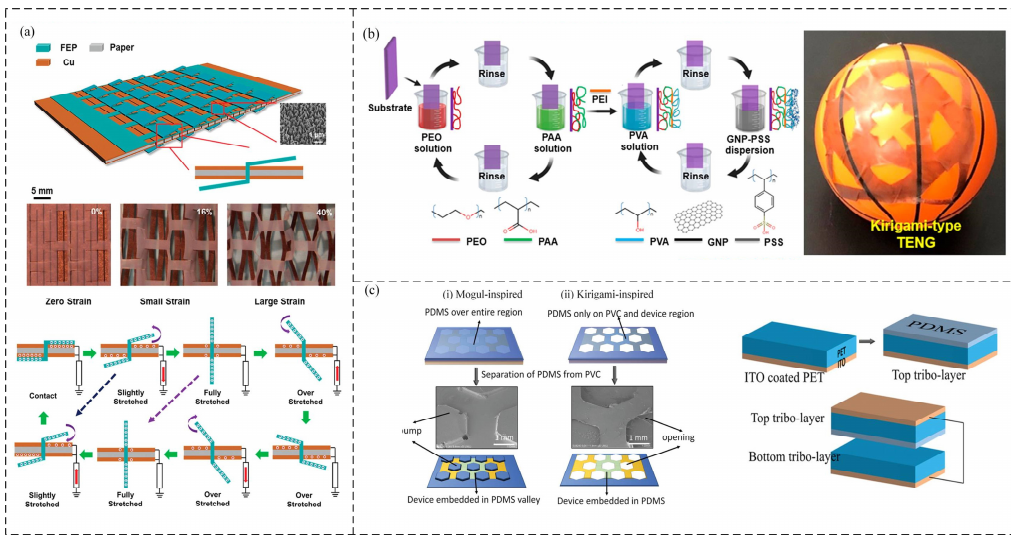
Figure 9. TENGs with kirigami structure. ( a ) Stretchable TENG with grid kirigami structure. Reprinted with permission from Ref. [124]. Copyright 2016 American Chemical Society. ( b ) Kirigami TENG with super stretching ability and extraordinary folding ability. Reprinted with permission from Ref. [125]. Copyright 2021 American Chemical Society. ( c ) Kirigami TENG with wearable photodetector function. Reprinted from Ref. [126].